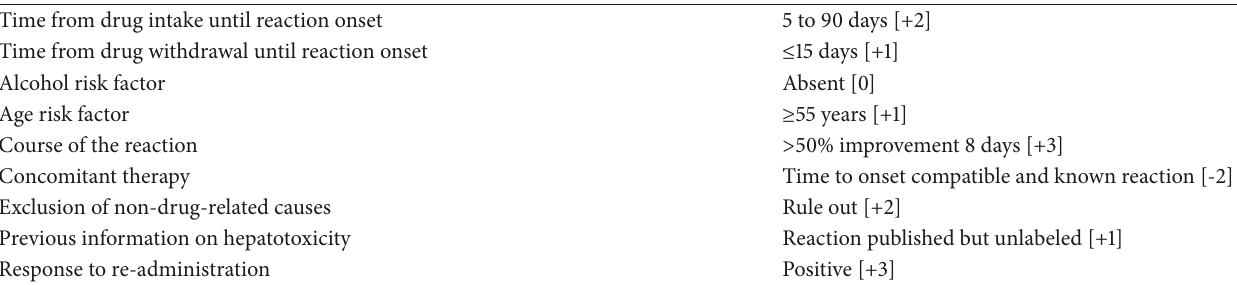
Table 2: Calculation of CIOMS score in our patient gave a score of